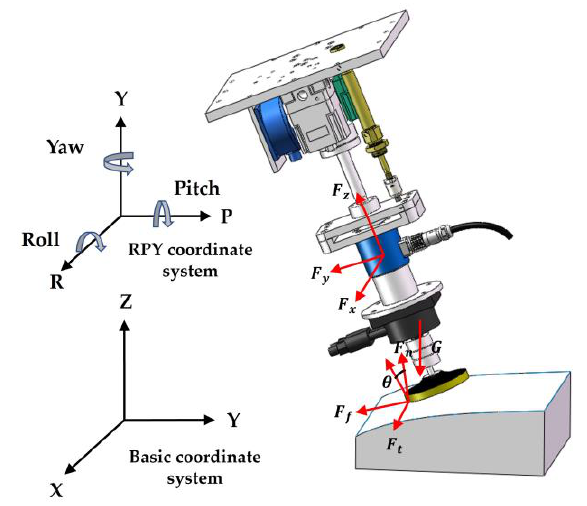
Figure 6. Force and coordinate system